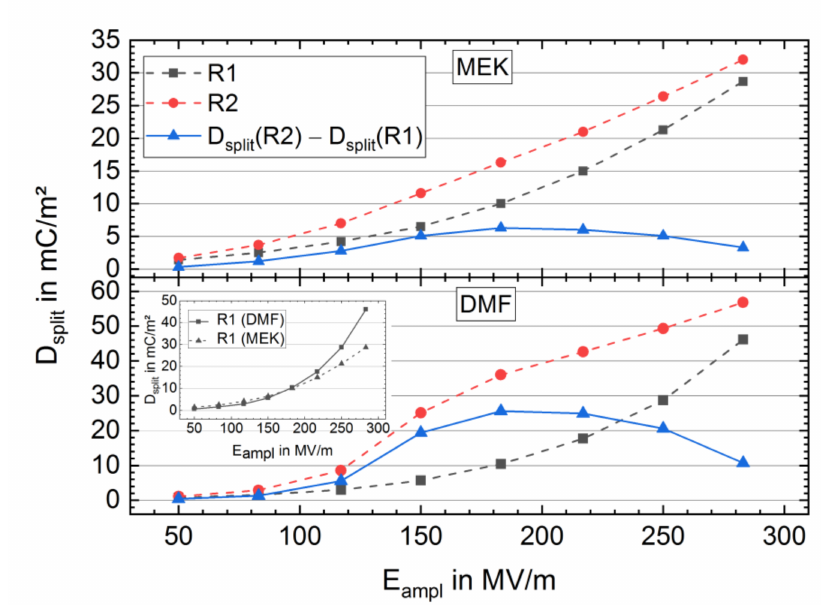
Figure 6. D-E curve gap at zero field D split vs. cycling field amplitude maximum E ampl of BE cycling run 1 (R1) (black) and BE cycling run 2 (R2) (red) for samples from MEK ( top ) and DMF ( bottom ) solution. Additionally, ∆ D 21 = D split (R2) − D split (R1) is shown (blue). The inset compares the two split samples in BE cycling run 1